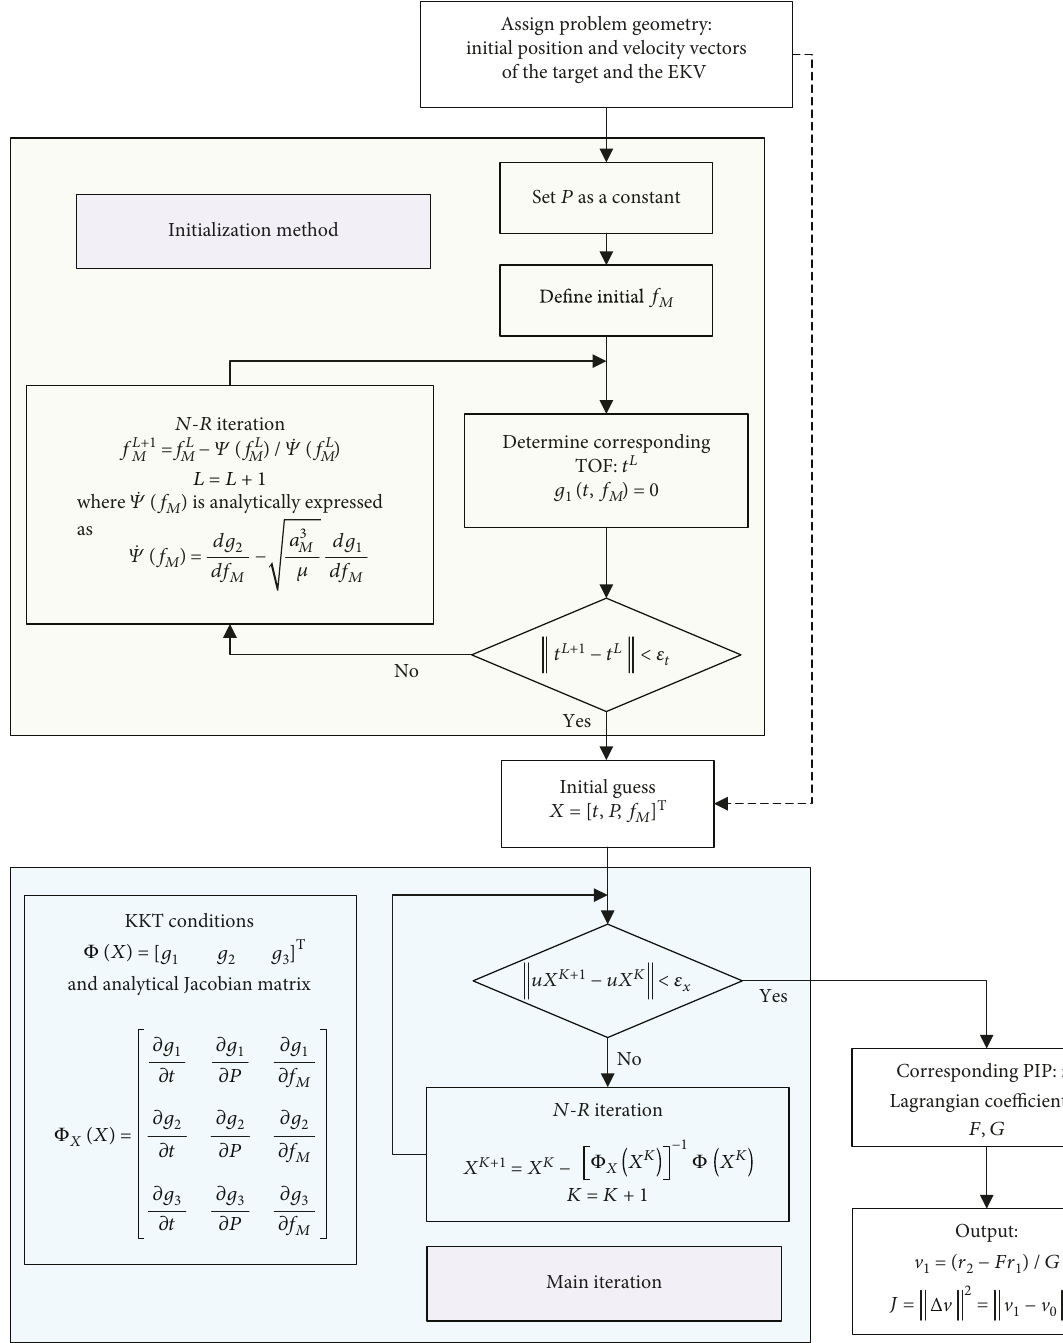
Figure 2: Flowchart of the proposed